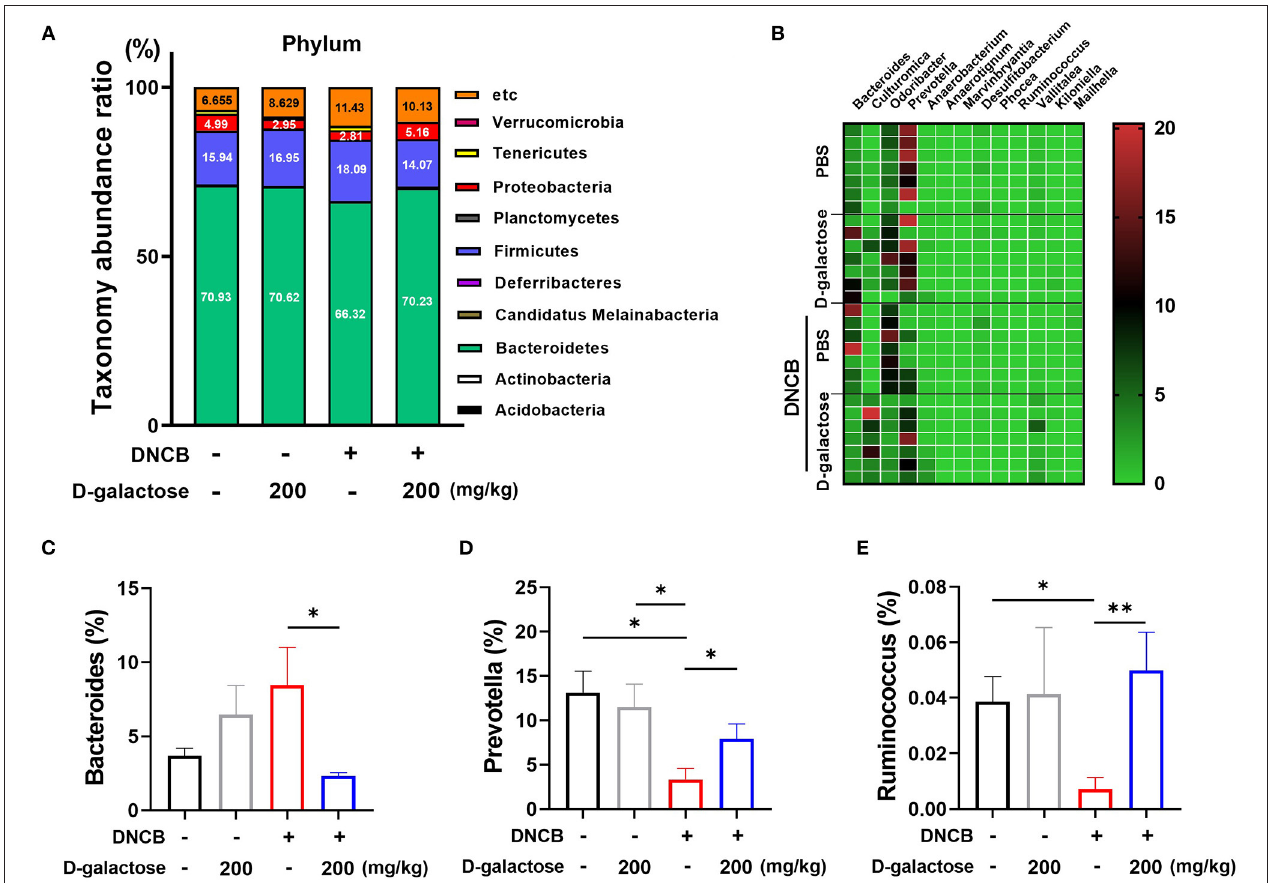
FIGURE 6 | Effects of D-galactose on intestinal microbiota composition in mice with DNCB-induced atopic dermatitis. (A) Relative abundance of bacterial phyla in the intestinal microbiota of mice. The color of each cell indicates the relative abundance of bacterial phyla. (B) Relative abundance of intestinal microbiota at the genus level in mice, which showed a significant difference between DNCB-induced AD groups. (C–E) Relative abundance of Bacteroides, Prevotella and Ruminococcus among the intestinal microbiota of mice. Values are means ± SD. Significant differences between the groups were assessed using Mann-Whitney U -test, with the level of significance set at * p < 0.05,** p < 0.01,*** p <